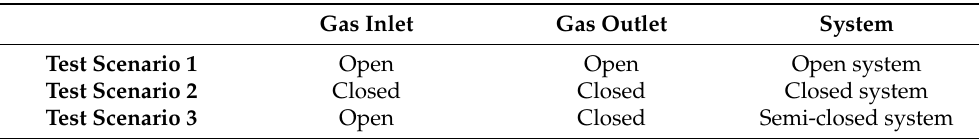
Table 4. Experimental conditions of the 3 parallel tests regarding the inlet valve and outlet valve of the Raman pressure